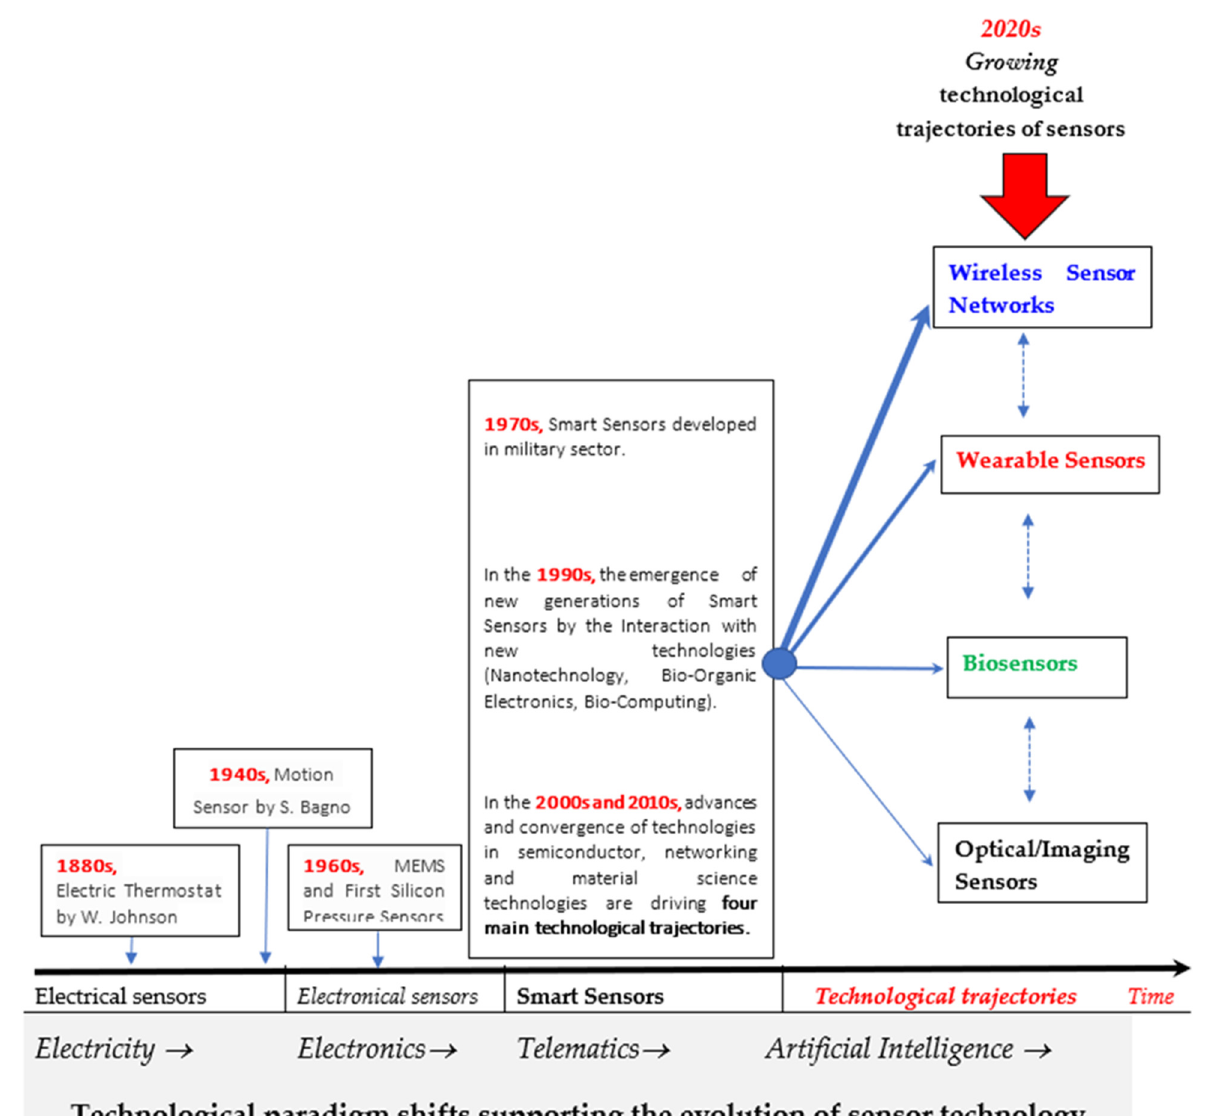
Figure 10. Macro evolution of sensor technology from electrical, (micro) electronic and smart sensors with scientific fields and technologies having high growth for pervasive and innovative development in industrial sectors. Note : A sensor is a device that detects changes in quantities. A greater ( smaller ) thickness of arrows indicates a higher ( lower ) intensity of scientific and technological growth of sensor technological trajectory, considering the coefficients of regression in Table 3.